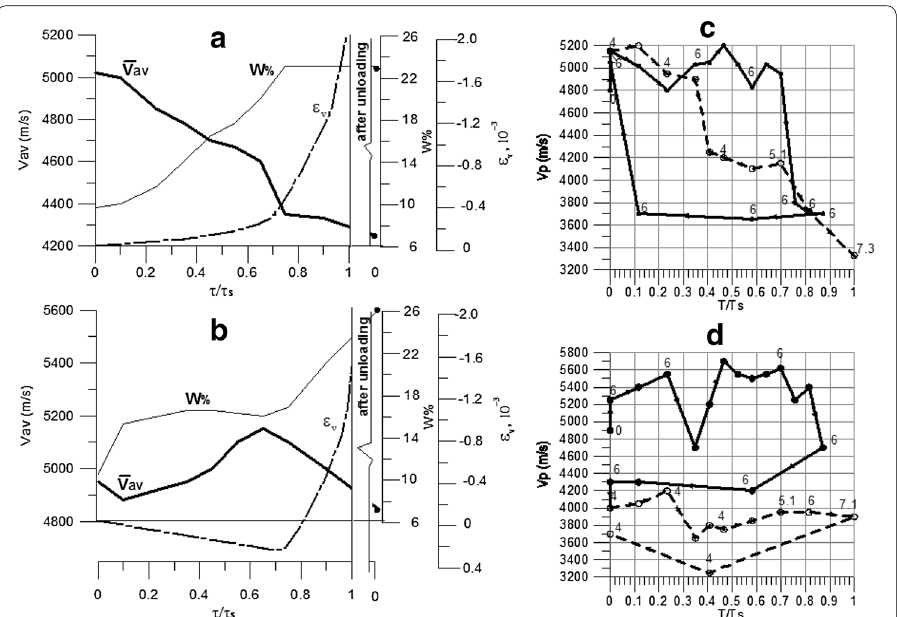
Fig. 10 Variations with loading level of the active zone velocity Vav, variation coefficient W% and summary active zone vertical deformation εv in the tensile ( a ) and shear ( b ) failure zone; ( c ) Active zone velocity vs loading level graphs in the tensile ( c ) and shear ( d ) failure zones at the repeated loading (digits are normal effective